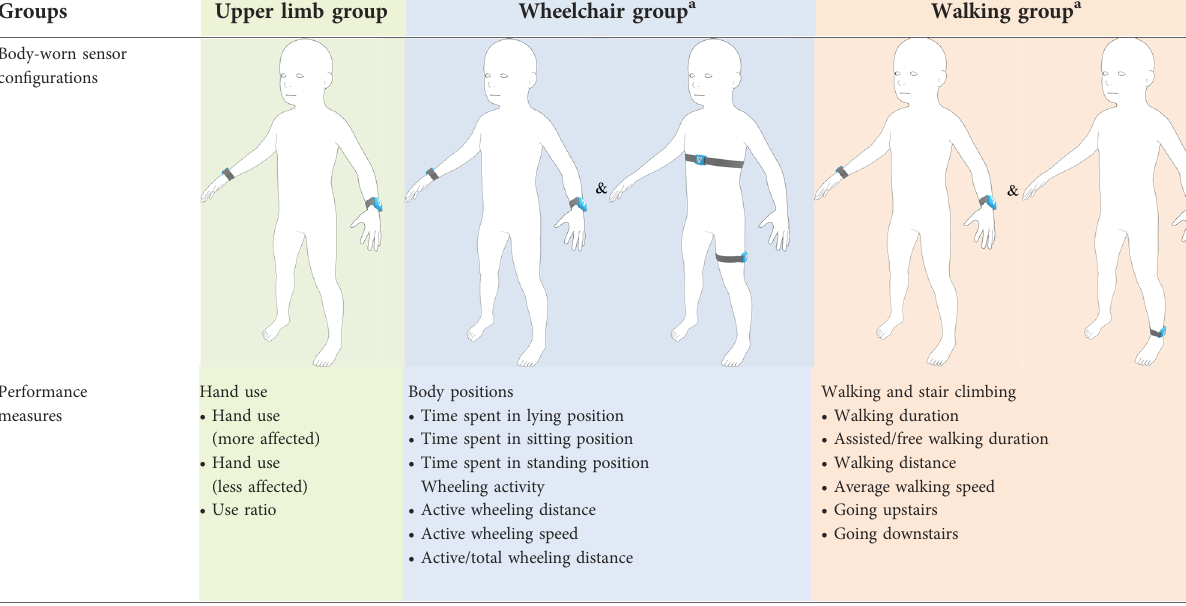
TABLE 1 Study groups, body-worn sensor con fi gurations, and performance measures.